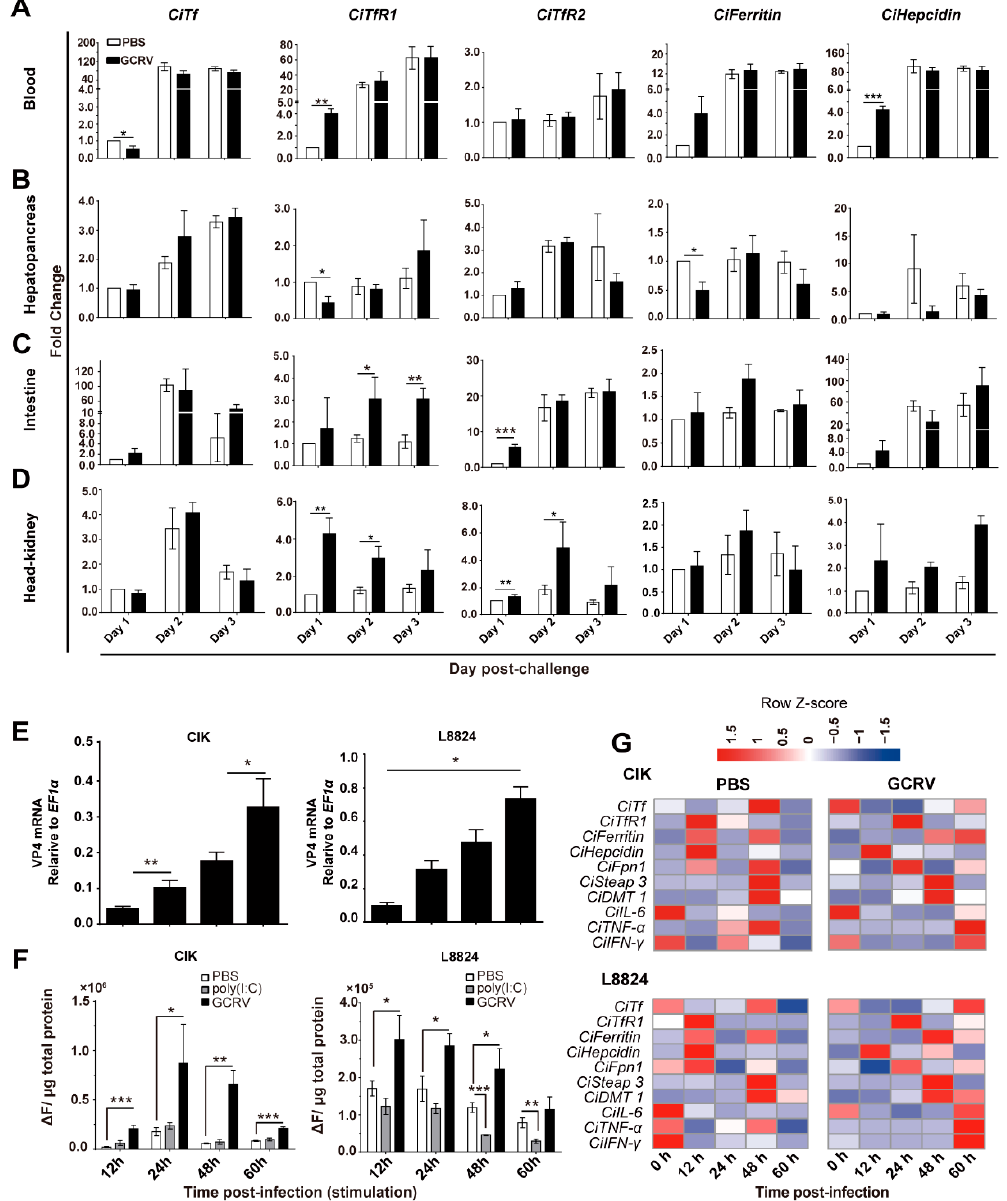
Figure 2. GCRV infection affects intracellular iron accumulation and the expression of iron metabolism-related genes (IMRGs). ( A – D ) GCRV infection influences the expression of IMRGs in vivo. Blood, hepatopancreas, intestine, and head/kidney samples were gathered at the indicated time points after GCRV injection. The relative mRNA expression levels of CiTf , CiTfR1 , CiTfR2, CiFerritin , and CiHepcidin in blood ( A ), hepatopancreas ( B ), intestine ( C ), and head/kidney ( D ) were detected, respectively. Y-axis represents the relative fold change. ( E ) The relative mRNA levels of VP4 in CIK and L8824 cells after GCRV infection. ( F ) The iron contents in CIK and L8824 cells increase after GCRV infection. Cells were evenly seeded into 24-well plates (5 × 10 5 /well), and then stimulated with poly(I:C) or infected with GCRV (MOI = 1) at 24 h cultivation. At the indicated time points, cells were harvested. The fluorescence value of each well was measured. ( G ) The relative expression profiles of IMRGs and IMRG regulation cytokines in PBS- and GCRV-challenged CIK or L8824 cells. Red indicates the relative high expression, while blue indicates low expression. Heatmap was plotted by using the heatmap.2 package of R program (http://www.R-project.org/). Data are presented in relative expression units where 18S rRNA ( A – D ) or EF1 α ( E , G ) was used to normalize samples. A total of 180 fish were used. Data represent mean ± SD of three independent experiments. * p < 0.05, ** p < 0.01, *** p < 0.001.